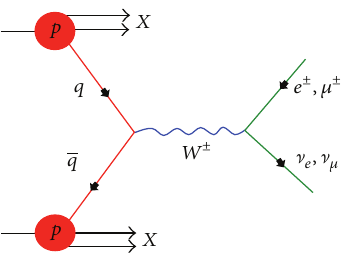
Figure 1: Leading order 𝑊 production diagram in 𝑝𝑝 collisions.